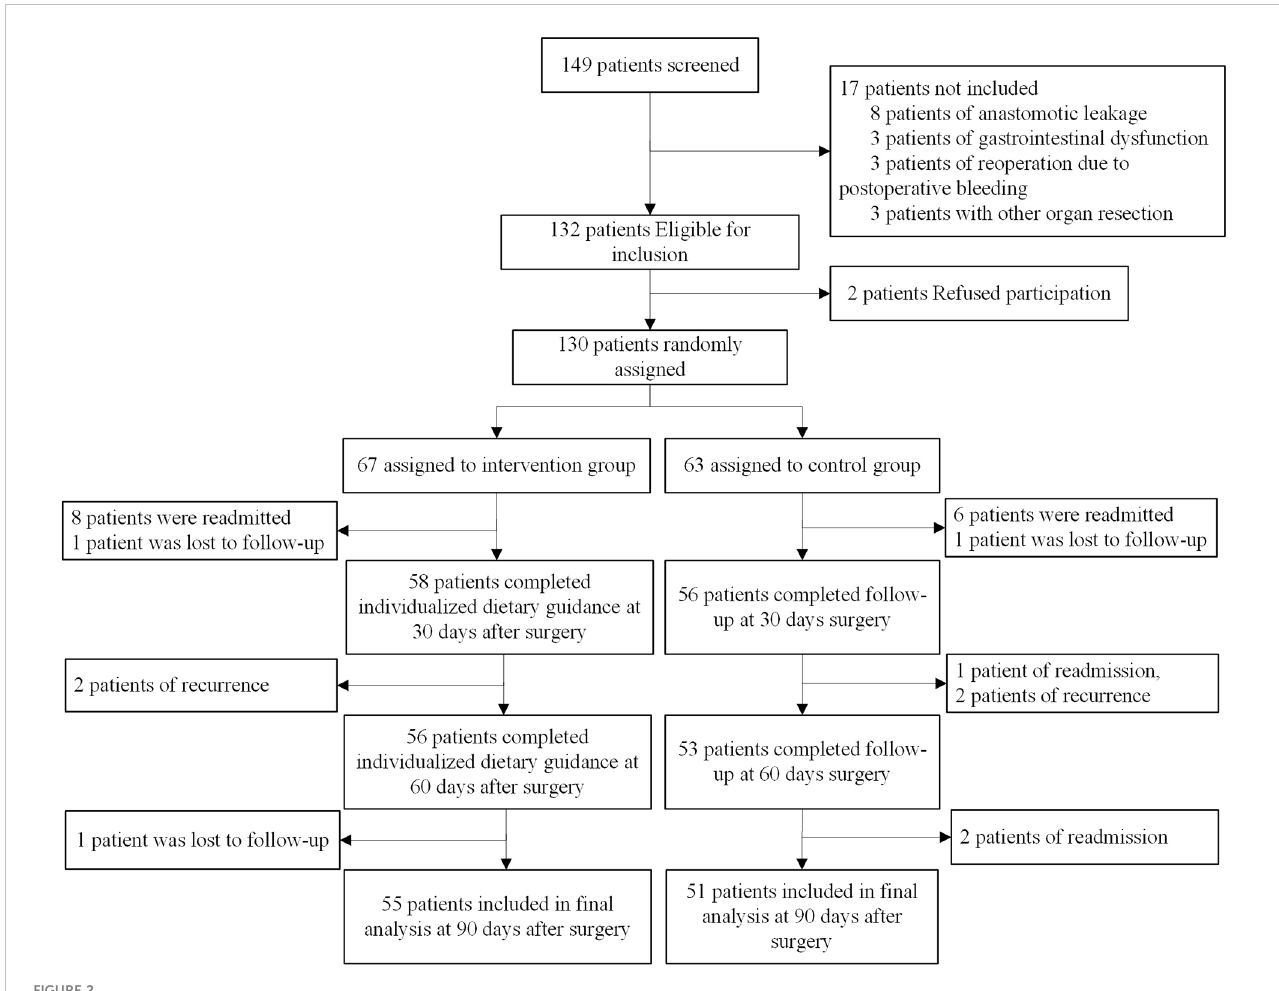
FIGURE 2 Trial pro fi